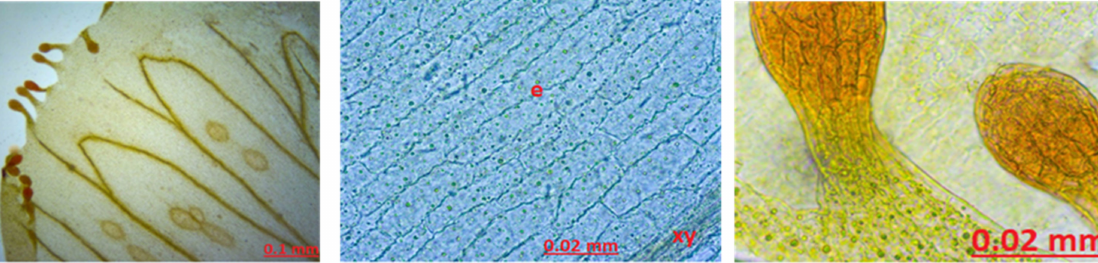
Figure 8. The stamen petal of Hypericum scabrum ; e: epidermis, xy: